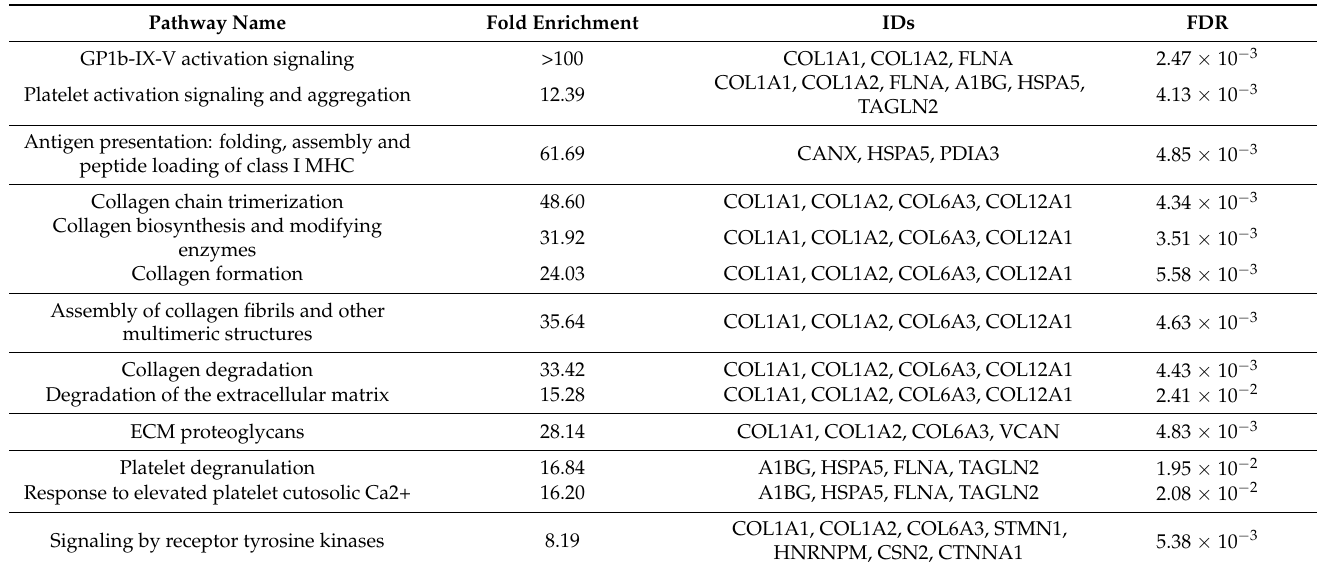
Table 2. Significant REACTOME enriched pathways. Results are sorted by the hierarchical relations between over- represented functional classes, which may be interpreted as a group rather than